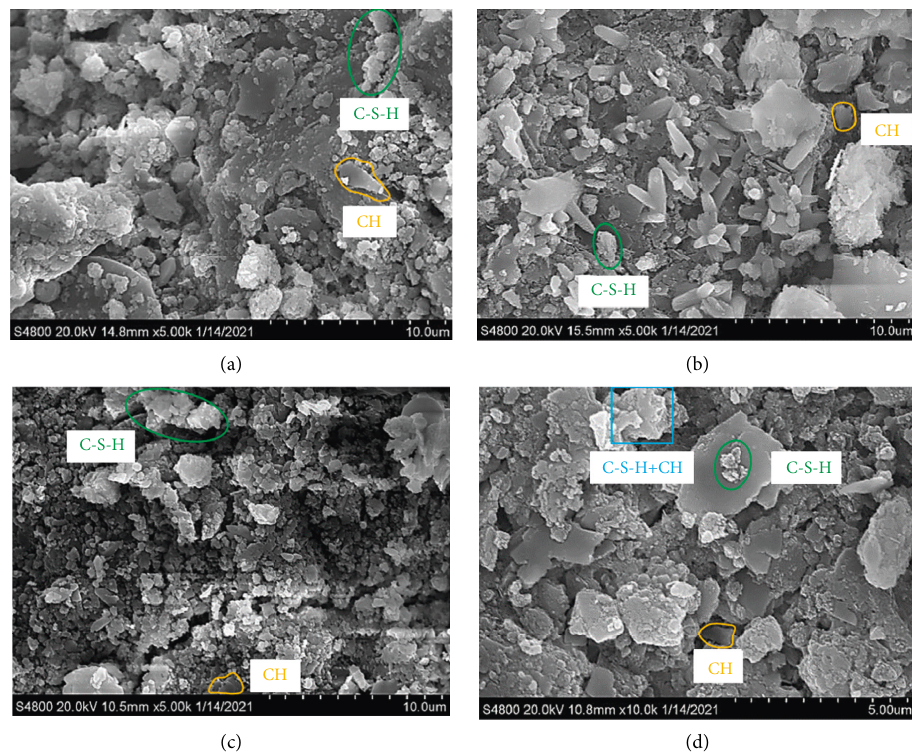
Figure 14: Micromorphology of cement concrete at different ages of control group: (a) 3d, (b) 14d, (c) 28d, and (d) 56d.